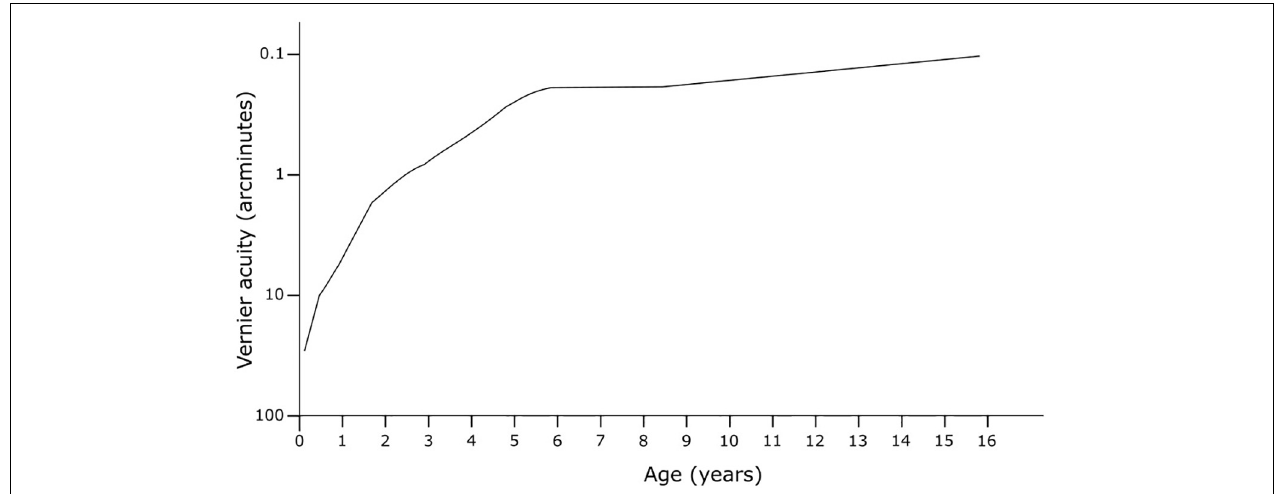
FIGURE 5 | Development of vernier acuity in early life. Adapted from Zanker et al.